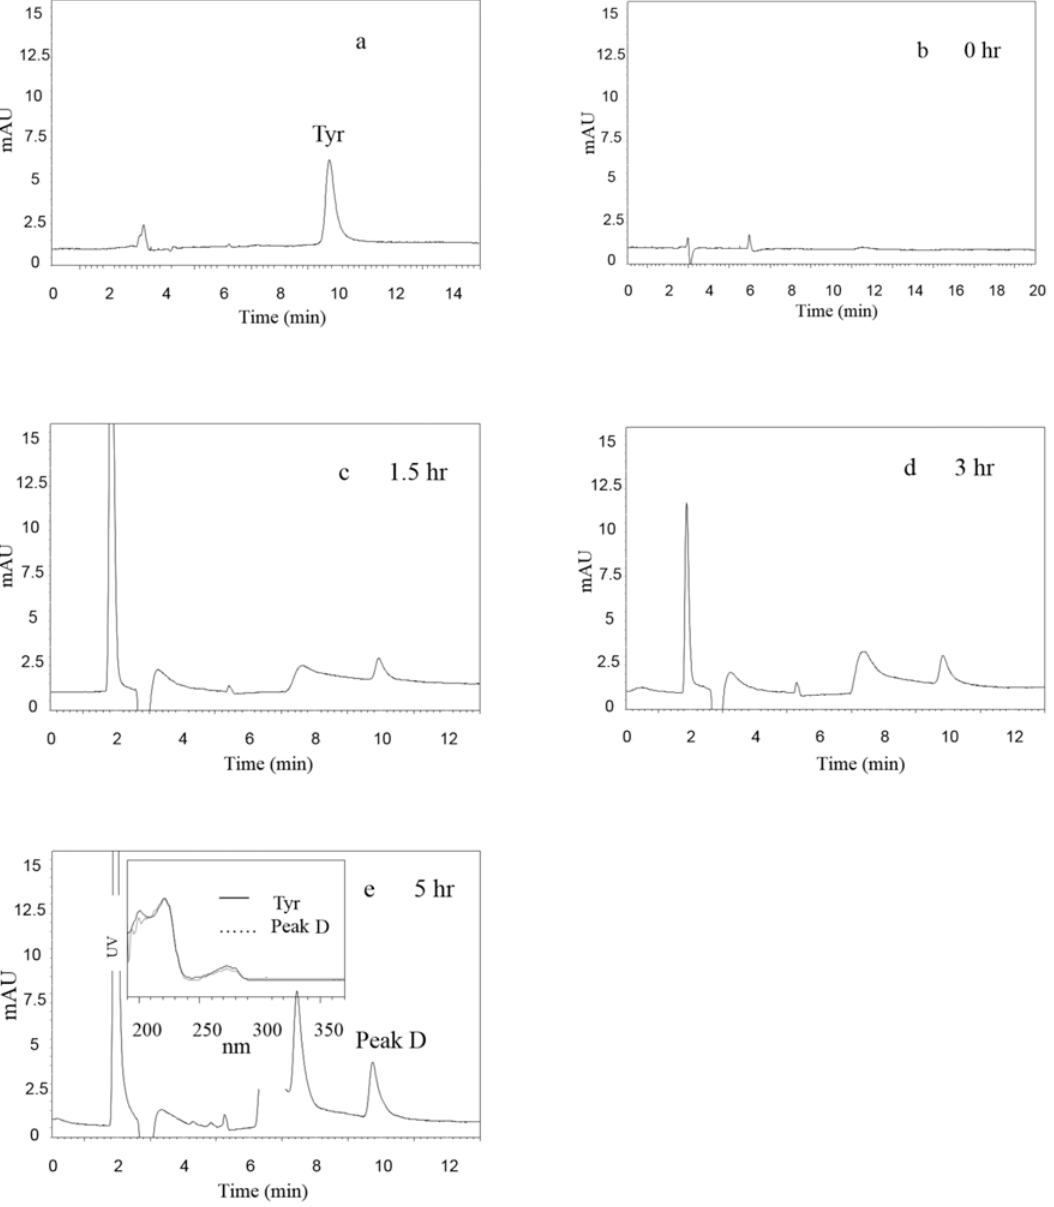
Fig 3. Enzymatic biodegradation of MC-YR by CEs of USTB-05 with time course and the scanning profiles of Tyr and its product at the ultraviolet wavelength from 200 nm to 370 nm.